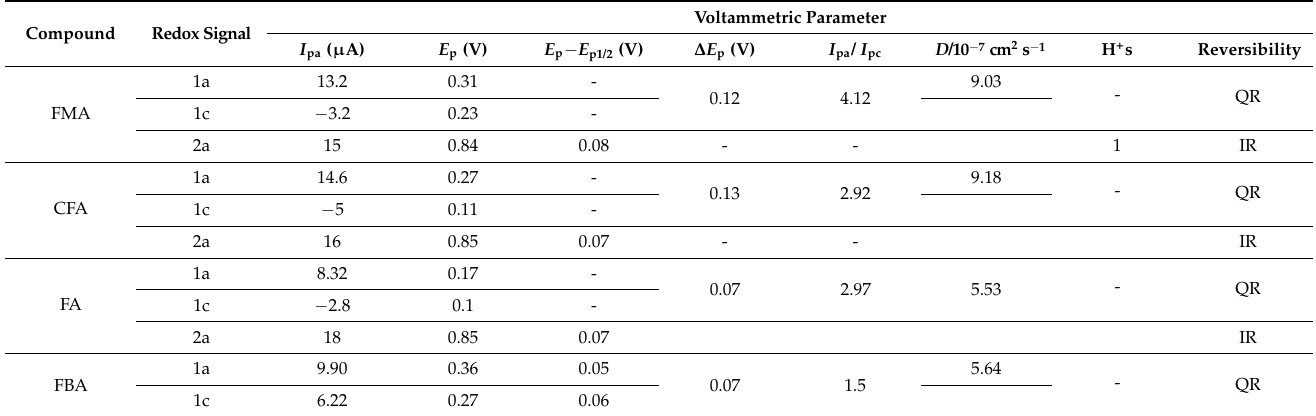
Table 1. Summary of electrochemical data obtained from CV.